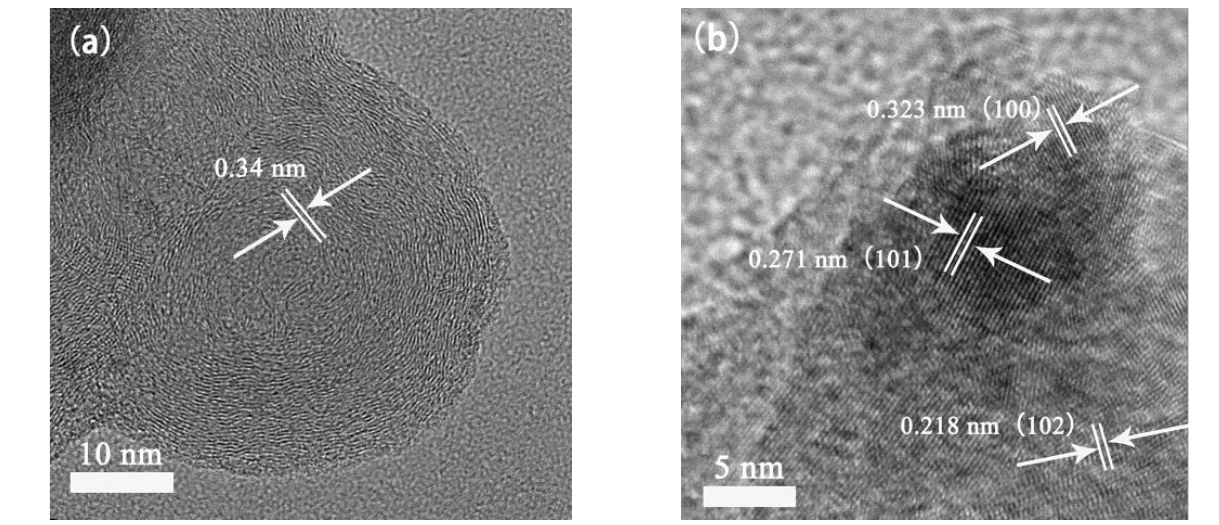
Figure 3. TEM image ( a ) and HRTEM image ( b ) of CS/1NC@3.